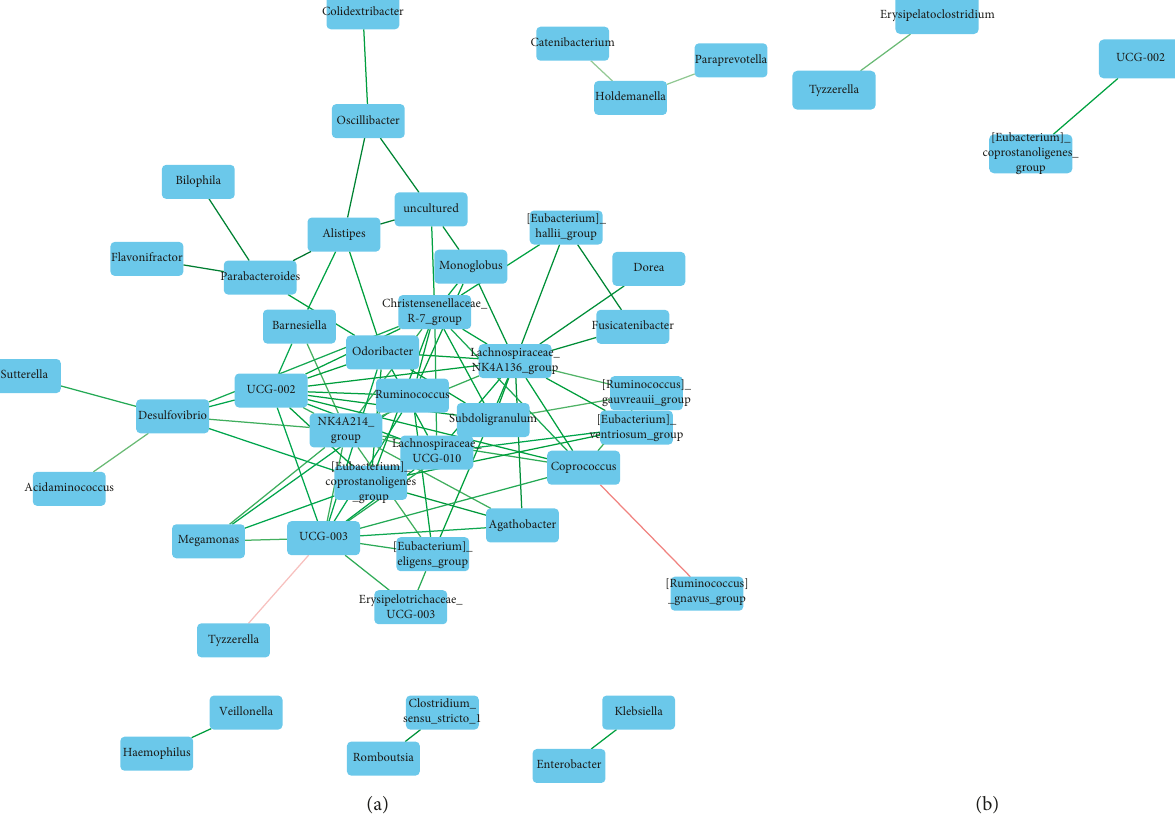
Figure 4: Cooccurrence analysis was performed to determine the interactions between gut microbiota at the genus level in obese (a) and nonobese (b) children. The color of the edges shows either positive (green) or negative (red) associations between genera. The color intensity of the edges indicates the relative strength of the association. Cooccurrences with a P value > 0.05 were removed. This analysis revealed 90 statistically significant copresence (positive) and mutual exclusion (negative) bacterial interactions among 43 genera in obese children. In contrast, the cooccurrence network at the genus level for nonobese children found only two statistically significant bacterial